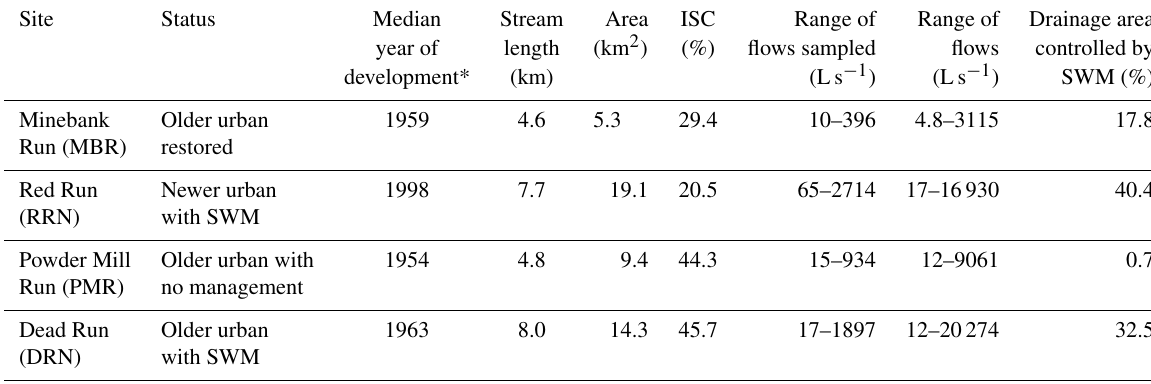
Table 1. Site characteristics for the four urban